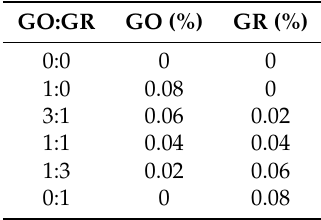
Table 2. Properties of cement.